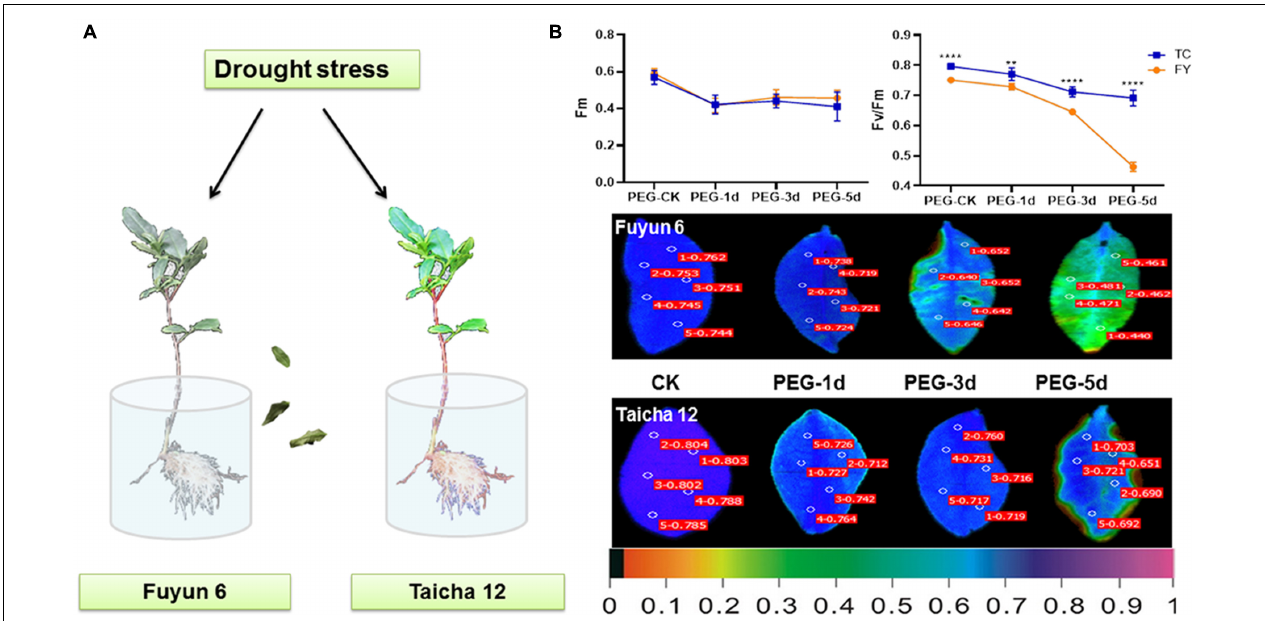
FIGURE 4 | (A) Schematic diagram of different tea varieties to drought. (B) Chloroplast fluorescence parameters of F m , F v / F m , and other leaves of different tea varieties under drought treatment. The false color code depicted at the bottom of the image ranged from 0 (black) to 1.0 (purple). t -test analysis, ** p < 0.005, **** p <